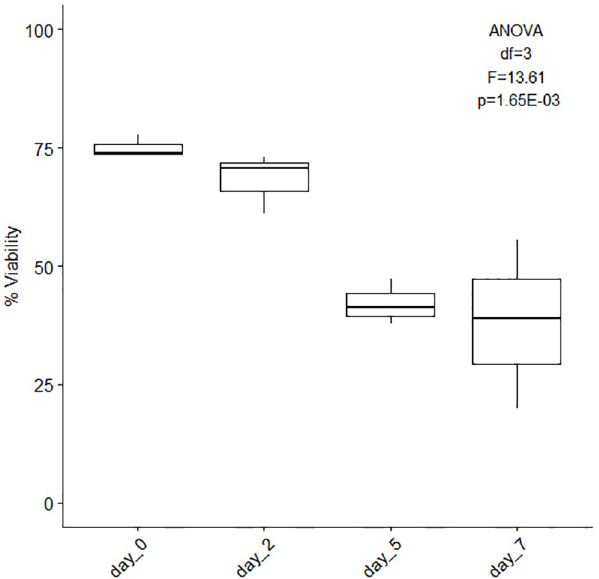
Fig 7. Cell viability (%) of 7-day cultures. Average overall cell viability (%, ± SE) of 7-day cultures. The cells were initially dissociated using Ca-Mg free seawater incubation for 1 hour and the culture medium used was composed of 15% DMEM, 10% FBS, 1% Penicillin-Streptomycin and 74% filtered artificial sterile seawater (replenished on days 2 and 5), n = 3. [ANOVA single factor, df = 3, F = 13.61, p =